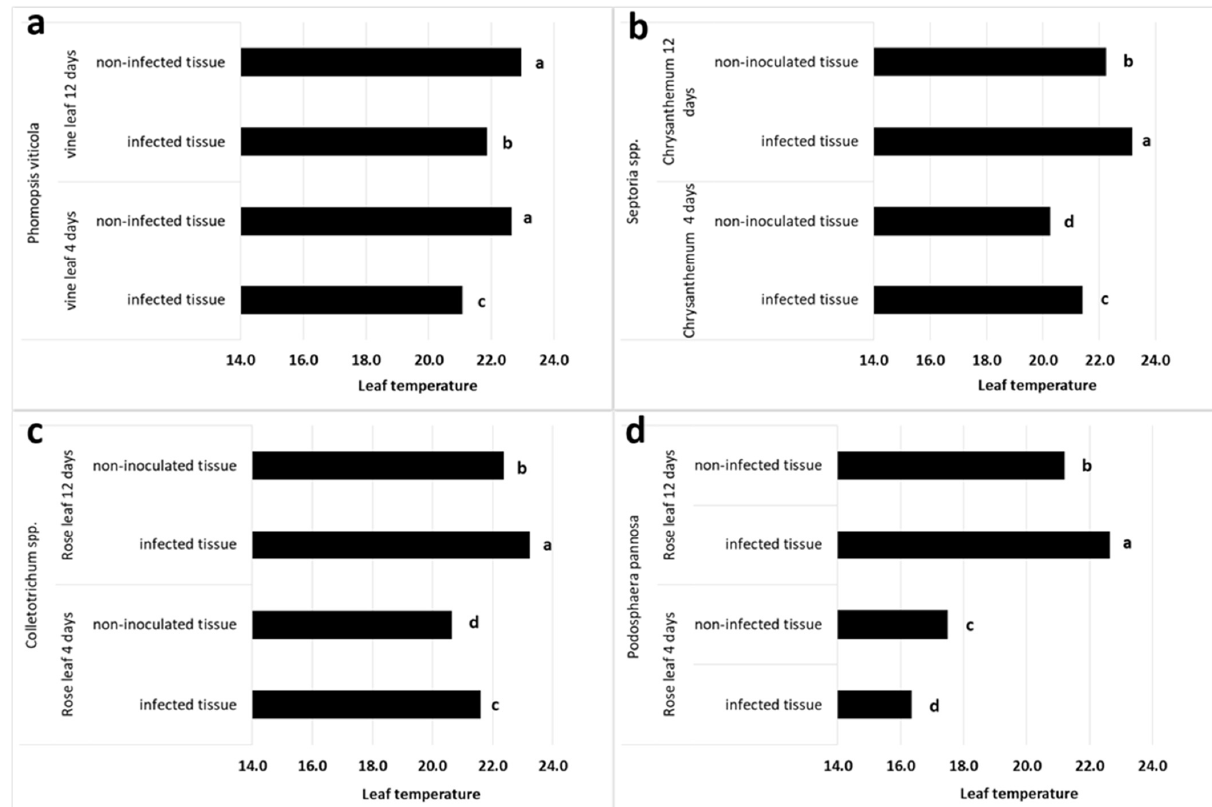
Figure 4. Infrared thermal imaging of vine leaves infected by Phomopsis viticola ( a ), chrysanthemum leaves inoculated with Septoria spp. ( b ), and rose plant leaves inoculated with Colletotrichum spp. ( c ) and with Podosphaera pannosa ( d ) after four and twelve days from infection or infection. The different letters above the figures indicate significant differences between treatments ( p <